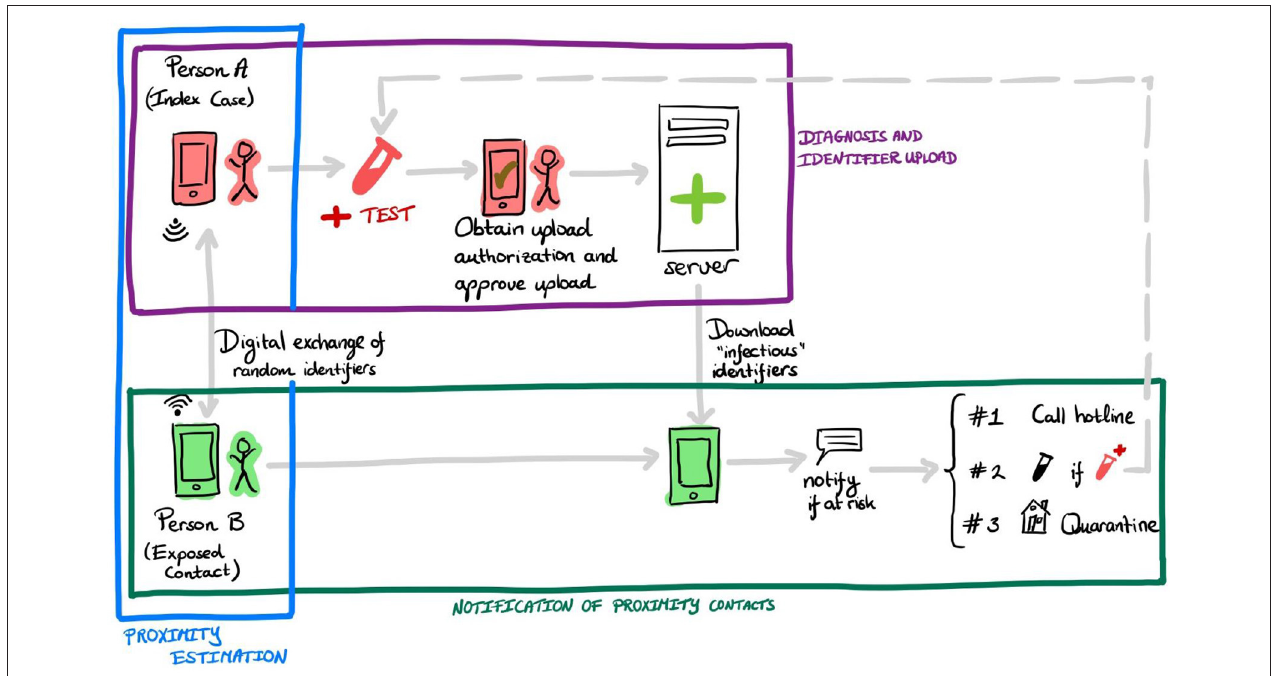
FIGURE 1 | Example of required steps in the notification cascade of digital proximity tracing in decentralized systems. An infected person A receives a positive test result for Sars-CoV-2 and (possibly automatically) an upload authorization. After consent by the user, the app uploads the random identifiers to a server. Person B’s device regularly downloads “infectious” identifiers. If B was in close proximity to A (or other infected users) for a prolonged time, then B receives the app notification. Upon receiving this notification, B has several options, for example—in some countries—calling an information line (#1), getting tested for Sars-CoV-2 (#2), or entering quarantine voluntarily (#3). The colored boxes refer to the three main tasks involved in the DPT notification cascade, described in section DPT Is a Complex Intervention